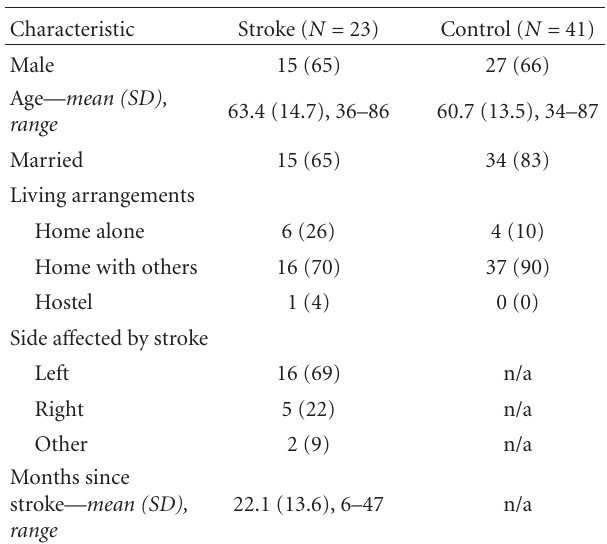
Table 2: Participant characteristics.